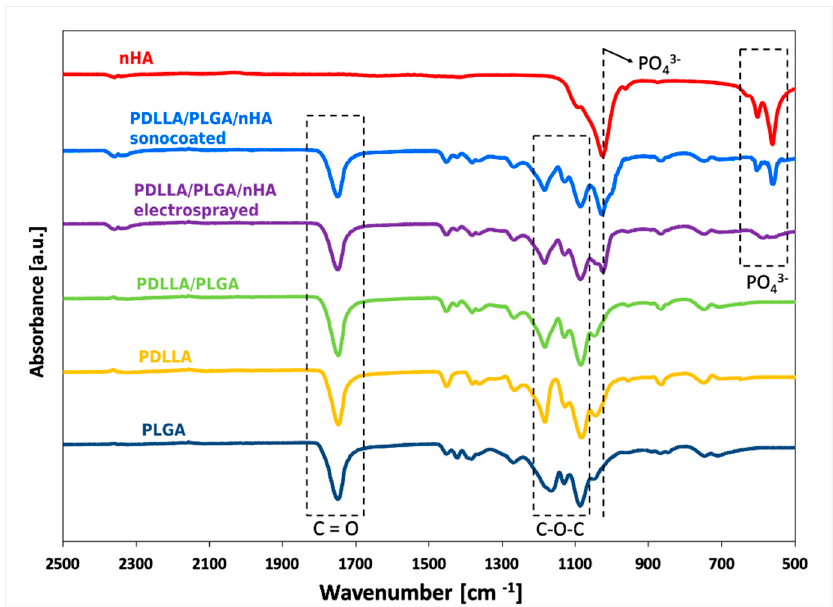
Figure 5. FTIR spectra of a: nHA, PDLLA, PDLLA/PLGA, and PDLLA/PLGA coated with nHA .